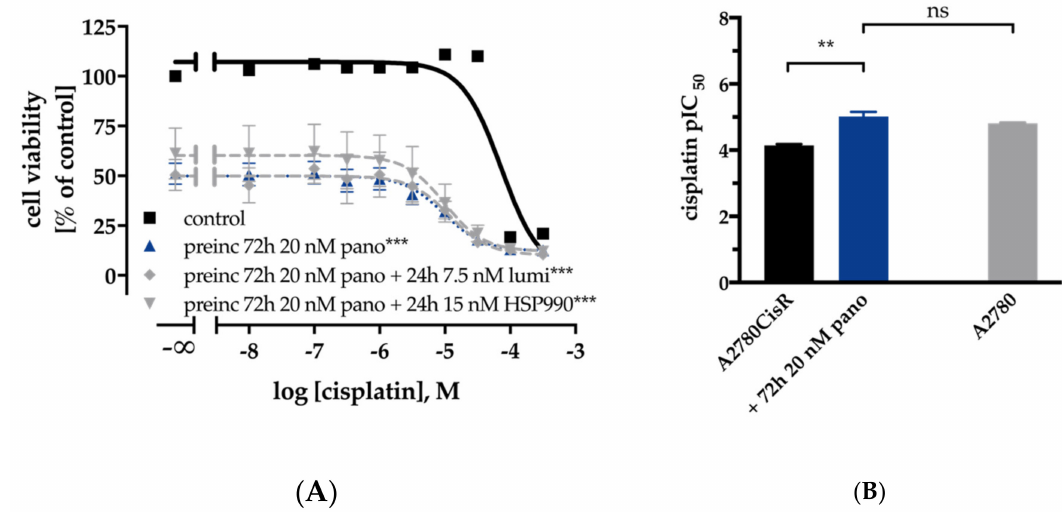
Figure 8. E ff ects of prolonged (72 h instead of 48 h) preincubation with HDACi / HSP90i on cisplatin sensitivity in A2780CisR ovarian cancer cells. 72 h preincubation with panobinostat or combination of 72 h of panobinostat with 24 h of luminespib or HSP990 prior to 48 h cisplatin treatment increased cisplatin sensitivity in A2780CisR ( A ). pIC 50 ± SEM values of cisplatin in A2780CisR using 72 h preincubation with panobinostat compared to A2780 ( B ). Results (IC 50 , pIC 50 , SEM, and shift factor) are summarized in Table S5. Statistical analysis was performed using t-test. Levels of significance: ns p > 0.05, ** p ≤ 0.01, *** p ≤